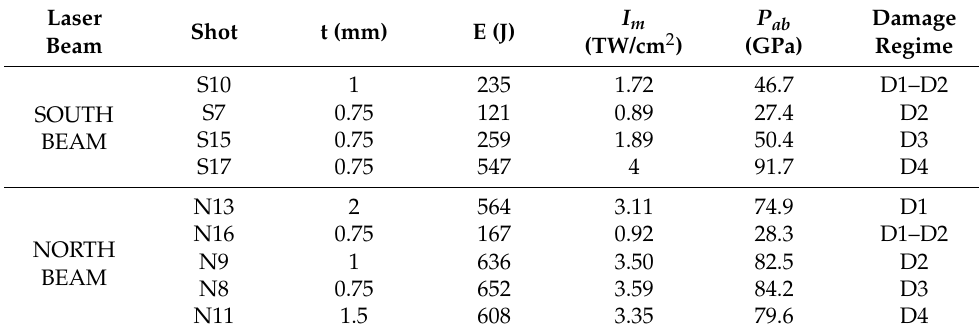
Table 1. Essential data on reference shots (adapted from [28]). t is the target thickness, E is the total delivered laser energy, I m is the peak laser intensity, P ab is the ablation pressure evaluated through the Grün formula